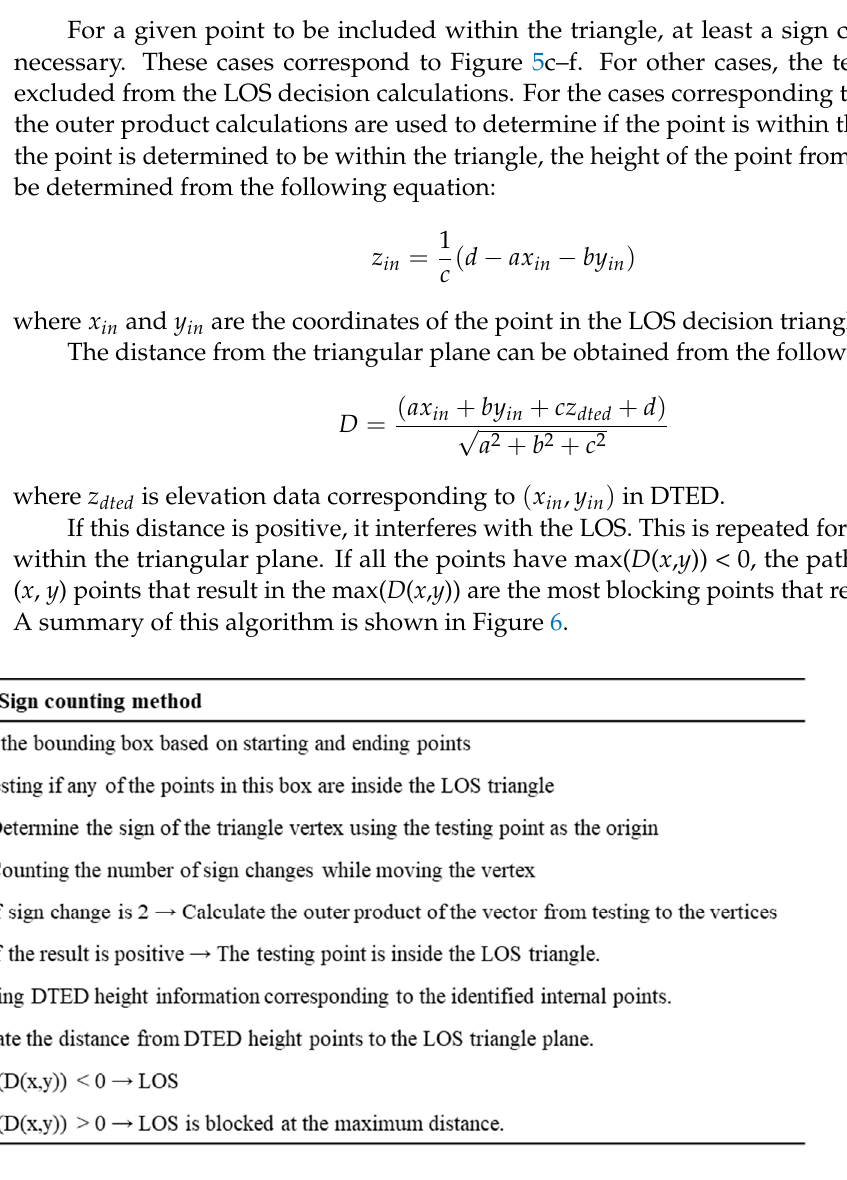
Figure 6. Algorithm to determine LOS.